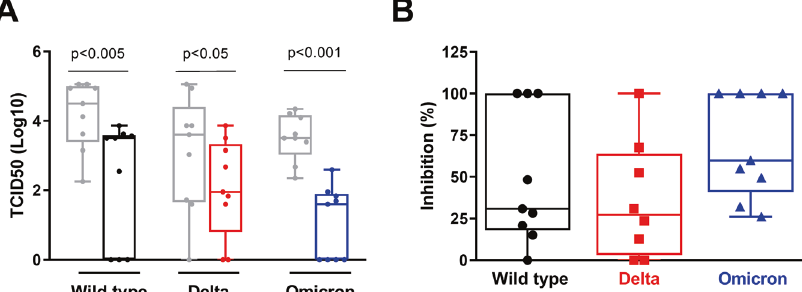
Fig. 4 Cysteamine decreases the production of SARS-CoV-2 variants in Calu-3 cells. ( A , B ) Calu-3 cells were treated with cysteamine (1000 µM) or H 2 O (1% v/v) 1 h before SARS-CoV-2 infection (MOI = 0.01) as indicated. ( A ) Virus yield of culture media from SARS-CoV-2- infected cells was measured by back-titration as described in the methods. Infectious titers were calculated with the Reed – Muench method and expressed as 50% tissue-culture effective dose (TCID50) values. ( B ) The ef fi cacy of the cysteamine treatment in Calu-3 cells was expressed as percentage of inhibition of the virus yields measured in panel A. Statistical analysis was performed using Wilcoxon matched-pairs rank test. Data are expressed as median ± S.D. ( n = 9) of three independent experiments performed in triplicate. We next asked whether cysteamine exerts the antiviral activity particles attached to the cell surface appeared reduced, cytoplas- against the SARS-CoV-2 VOC also in the lung-derived epithelial mic vacuoles containing viruses were found (Fig. 3D). Notably, by cellular model Calu-3. Cells were treated for 1 h with either ultrastructural observations we found that cysteamine reduced cysteamine (1000 µM) or H 2 O (1% v/v) as control, before SARS- Omicron variant infection in the majority of the cells. A limited number of cells displayed large vacuoles; few mature viral CoV-2 infection (MOI = 0.01) and then cultured in the presence of particles were visible either along the cell surface or inside the the drug, which was added to the medium 24 h after infection cytoplasmic compartments (Fig. 3F). until the end of the experiments (48 h.p.i.), when the culture